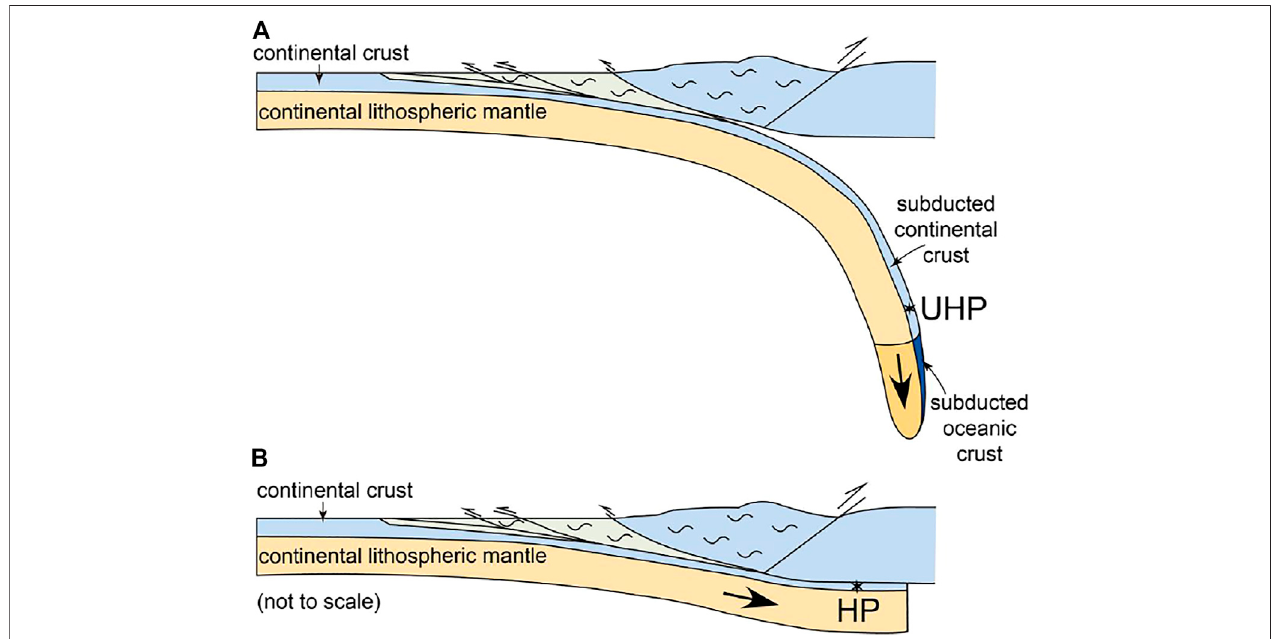
FIGURE2| Schematicdiagramsshowingtherelationbetweensubductionangleandmetamorphism. (A) Steepsubductionofcontinentallithosphere triggeredby downgoing oceanic lithosphere would produce UHP metamorphism. (B) Low-angle (shallow) subduction leads to the underthrusting of continental lithosphere producing HP metamorphism.